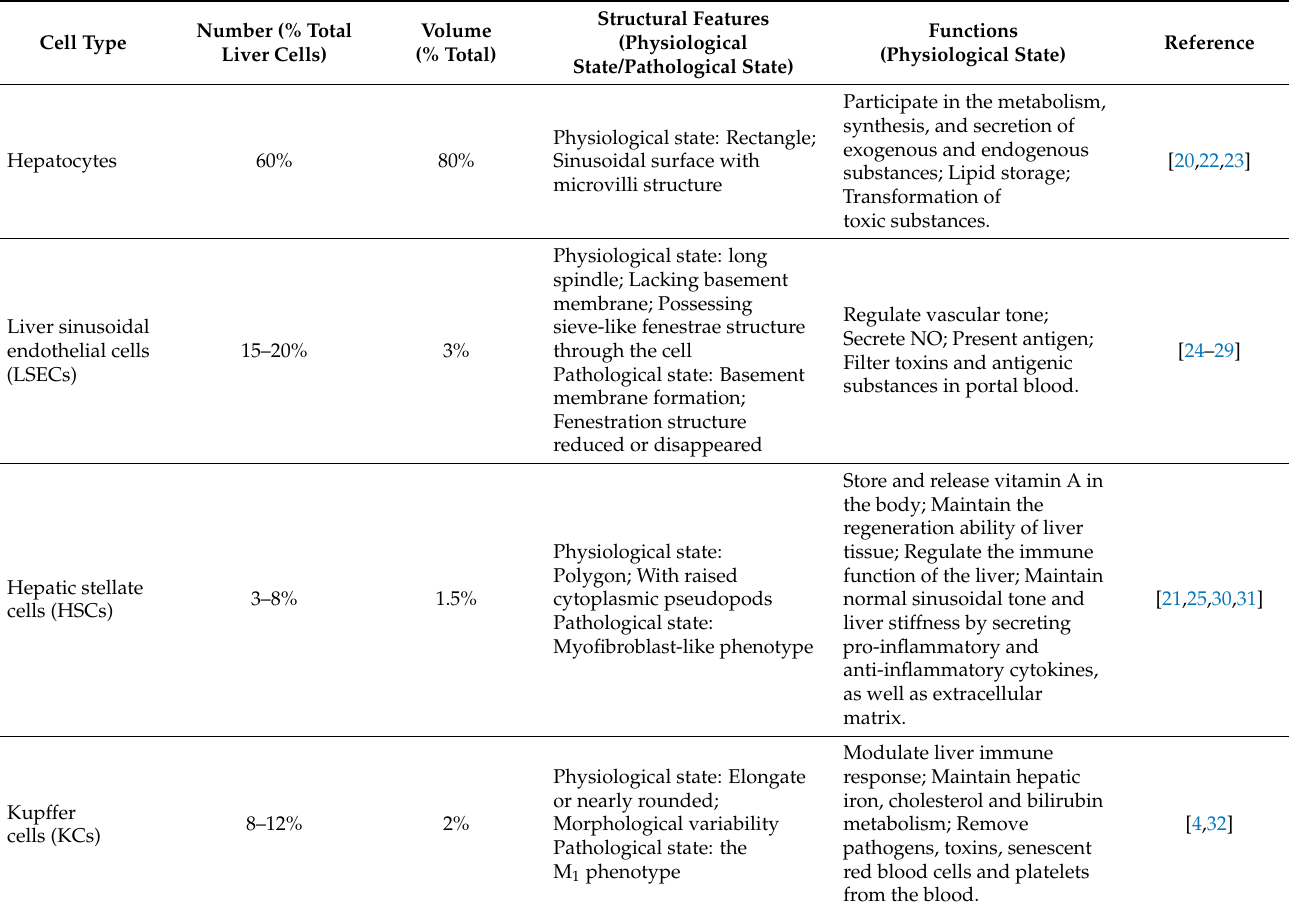
Table 1. Structure and function of the major liver cell